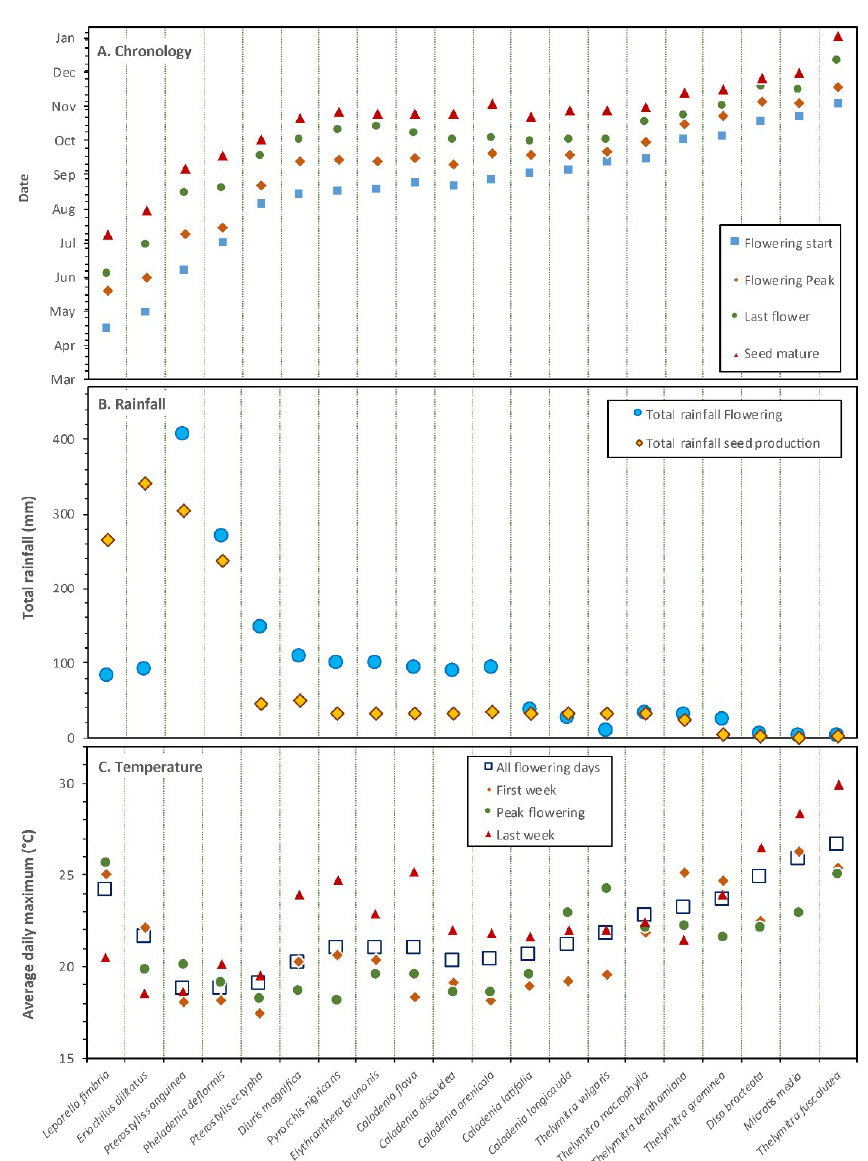
Figure 4. Climatic trends for the main orchid species in this study; ( A ) The timing of flowering and seed production; ( B ) Total rainfall during periods of flowering and seed production; ( C ) Temperature trends during flowering periods.